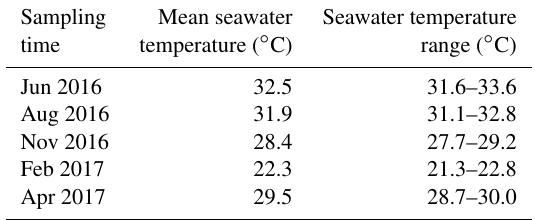
Table 1. Annual variation of in situ seawater temperature. Mean seawater temperature values are daily averages of in situ seawa- ter temperature and temperature range indicate daily oscillations (minimum–maximum). Seawater temperature was recorded every 10min over 24h for each sampling event.